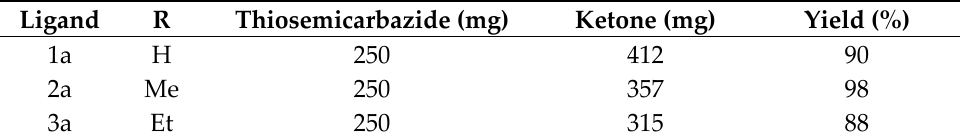
Table 1. Quantities of reagents added.